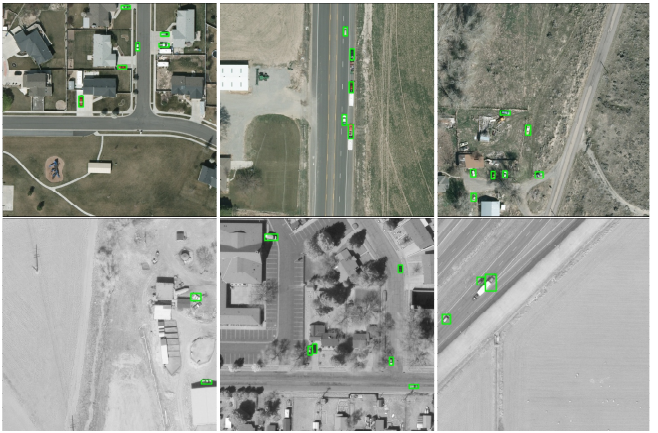
Figure 12. Detection results for VEDAI detection with the proposed method.